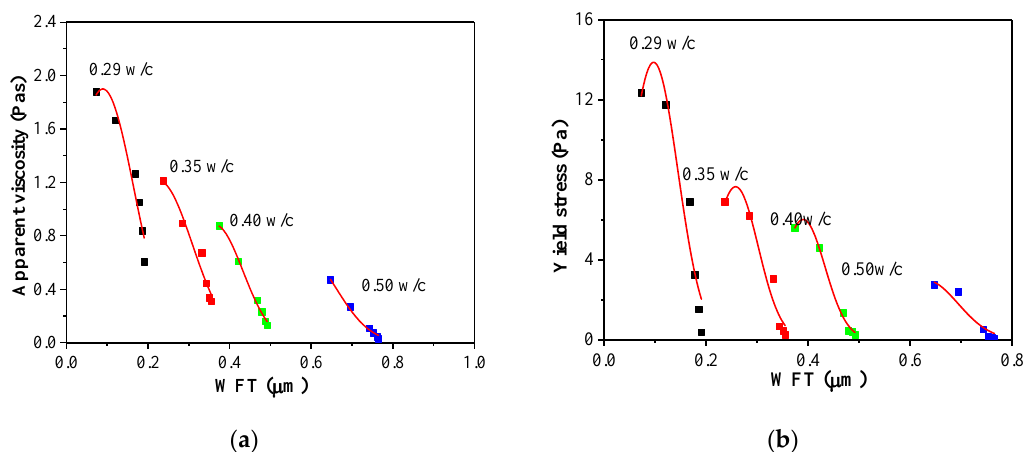
Figure 8. Yield stress and apparent viscosity versus WFT. ( a ) Yield stress versus WFT; ( b ) Apparent viscosity versus WFT. Table 3. The fitting equations and R 2 value of yield stress and apparent viscosity versus WFT. Yield Stress Versus WFT Viscosity Versus WFT w/c Ratios Fitting Equations R 2 Fitting